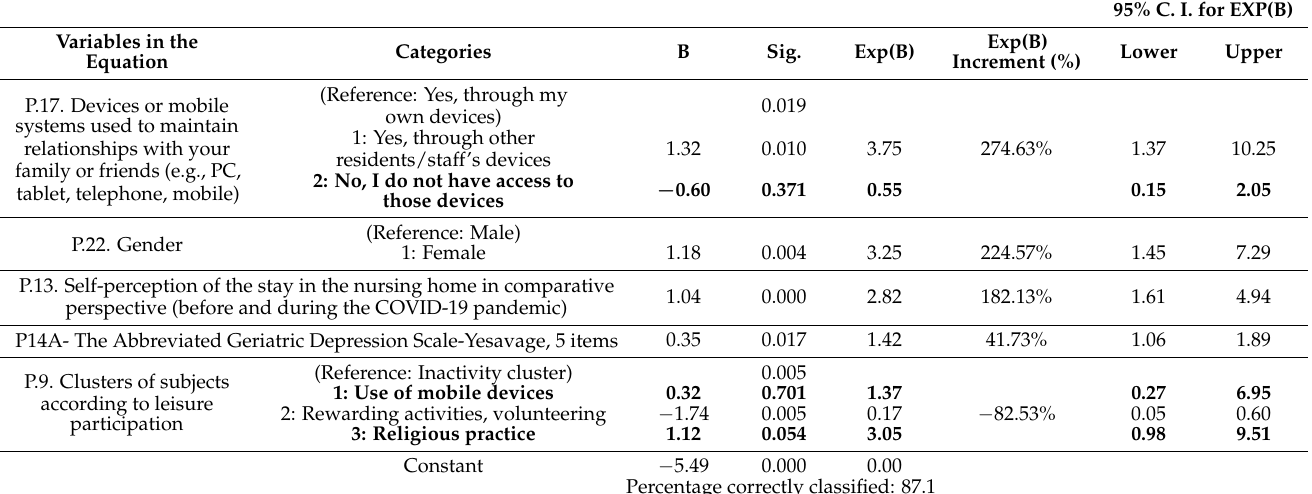
Table 3. Logistic regression model for residential assessment cluster 2: Low rating for mobility in the residential environment.